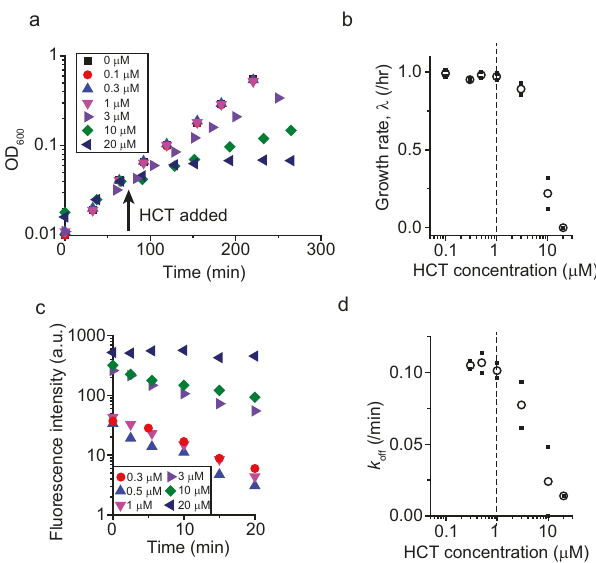
Fig. 1 λ and k off at various HCT concentrations. a , b HCT slows down the growth of E. coli cells in bulk culture at concentrations above 1 μ M. A t -test (one-tailed) between the growth rates for 1 and 3 μ M shows a P -value equal to 0.0325. Therefore, their difference is considered to be statistically signi fi cant. This agrees with a noticeable and persistent difference of OD 600 between 1 and 3 μ M treatment cultures ( a ). c , d Cells were pre-incubated with HCT and suspended in HCT-free media (which de fi nes time zero). For each data point, the intracellular HCT intensities of ~150 cells were measured and averaged. The slope of the intensity change re fl ects the k off . The k off decreased at HCT concentrations above 1 μ M. a and c show data from a single experiment. A biological replicate was conducted to con fi rm that the pattern was reproducible. Small solid symbols in b and d indicate the data from two biological repeats, and the open symbols indicate their